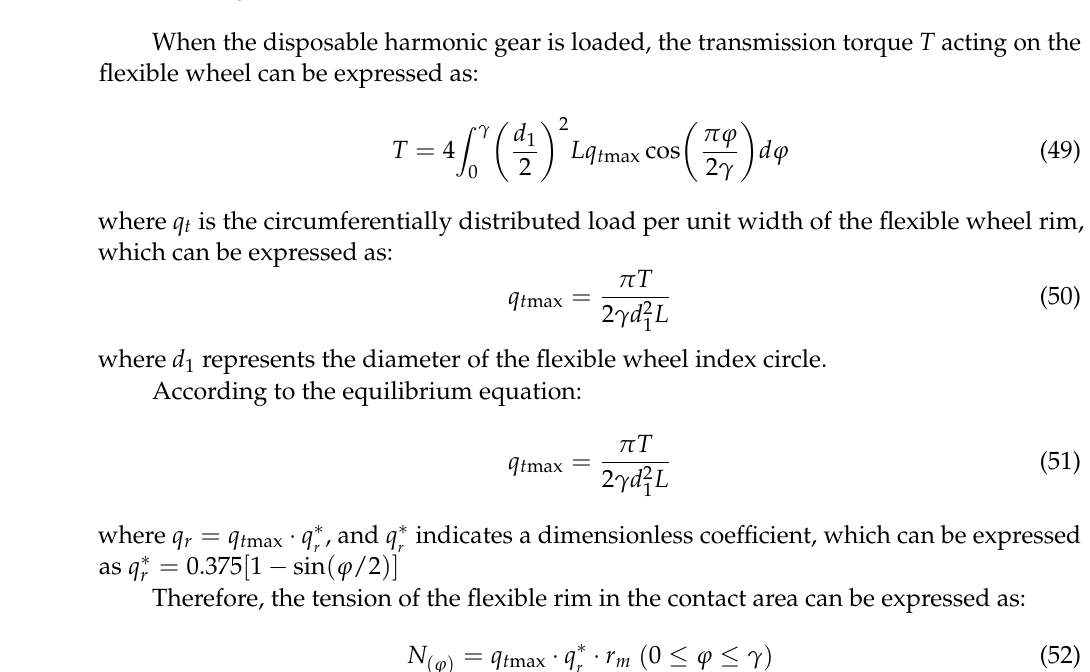
Figure 14. ( a ) Contact region distribution of the disposable HD; ( b ) internal force calculation schematic diagram of the flexible rim in the contact area.